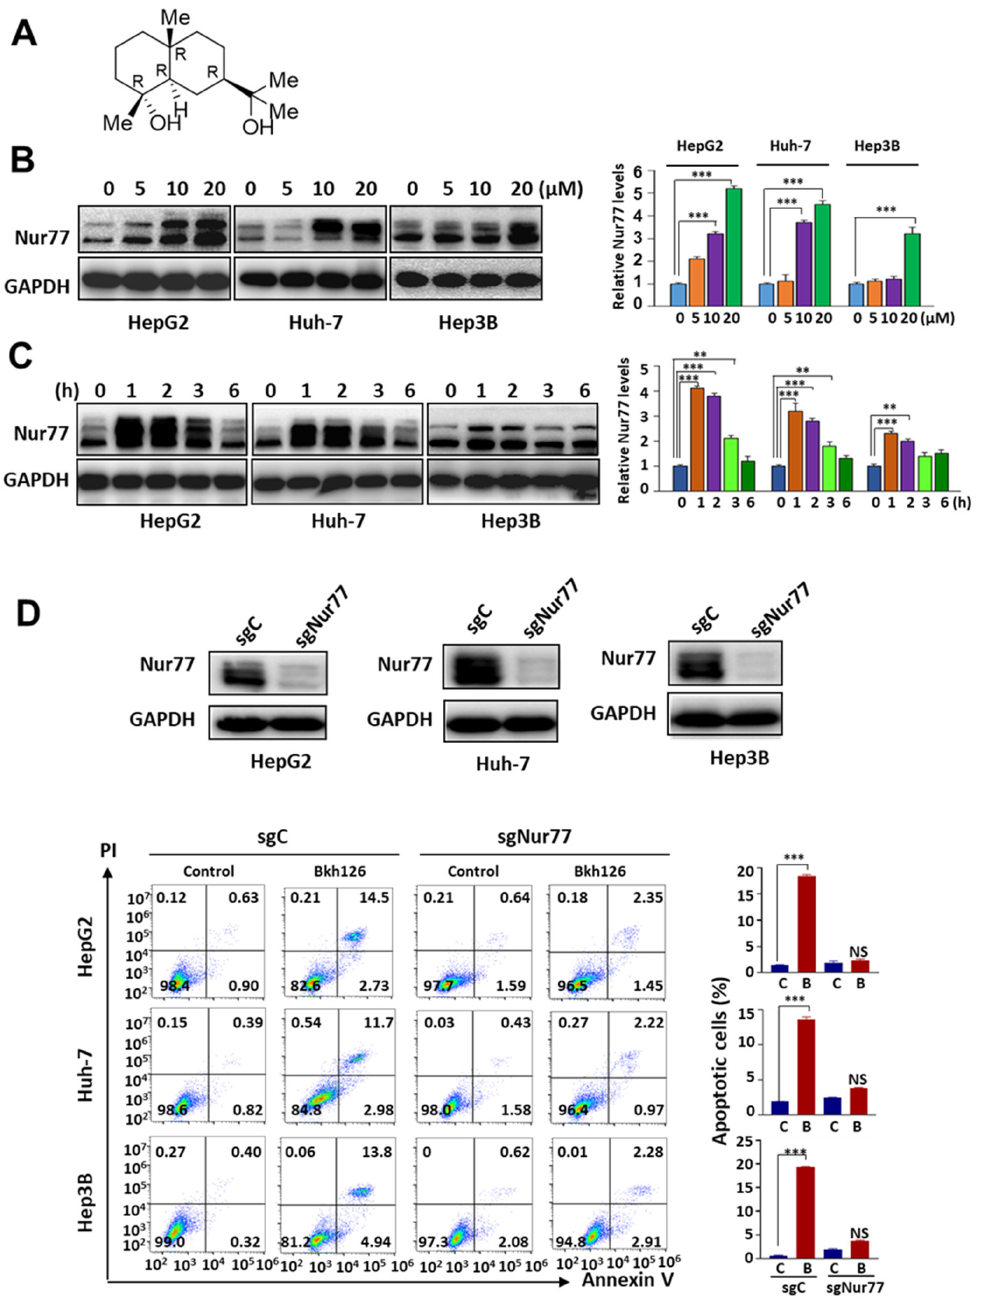
Figure 1. Bkh126 induces Nur77 expression and HCC cell apoptosis: ( A ) Chemical structure of Bkh126. ( B , C ) HCC cells were treated with different concentrations of Bkh126 for 2 h or with 20 µ M Bkh126 for different time intervals. Vehicle treatments served as controls. Cells were lysed and blotted with anti-Nur77 and GAPDH. ( D ) HCC cells and their Nur77 KO cells were treated with vehicle or 20 µ M Bkh126 for 24 h. The apoptotic rates were calculated based on AnnexinV/PI staining. ** p < 0.01 and *** p < 0.001. C, control; B,